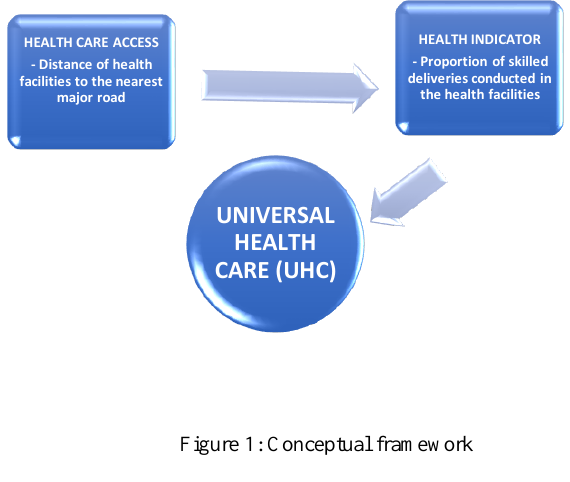
Figure 1: Conceptual